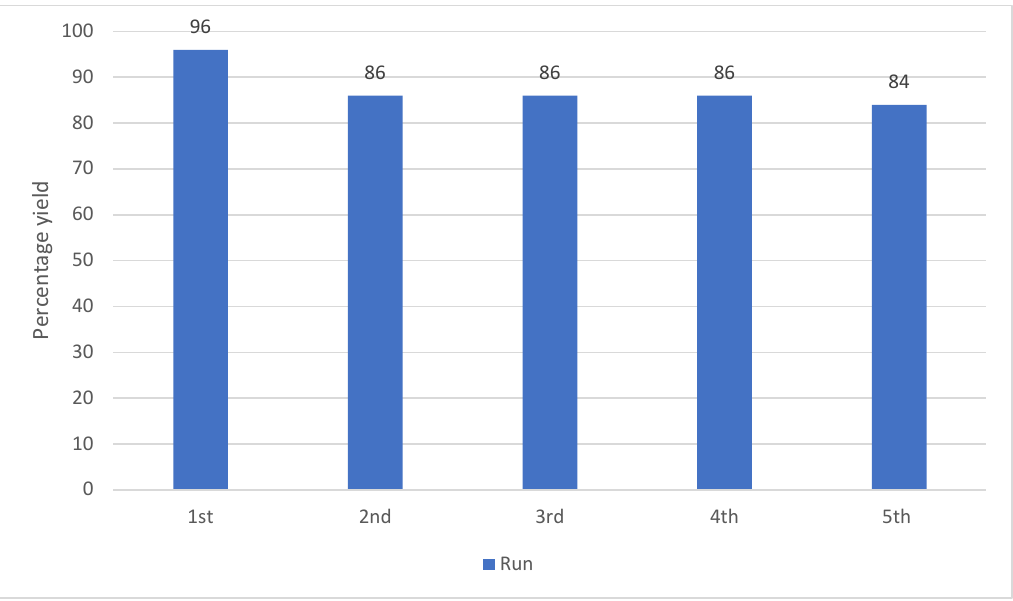
Figure 4. Recycling runs for the synthesis of model reaction product 3a .